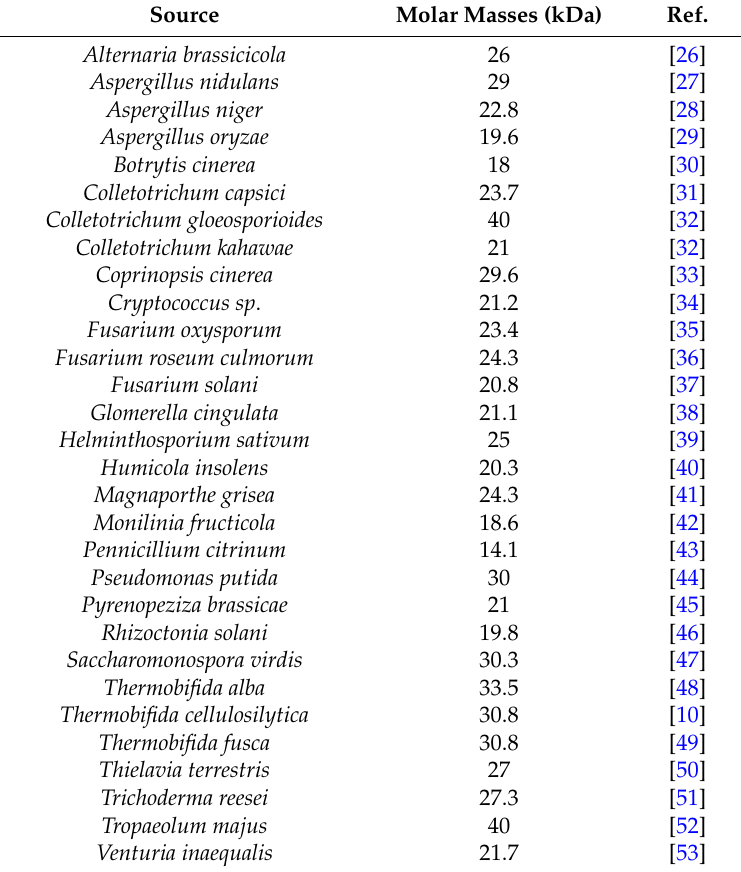
Table 1. Isolated and characterized microbial cutinases. For each entry the microbial source is indicated as well as the molar